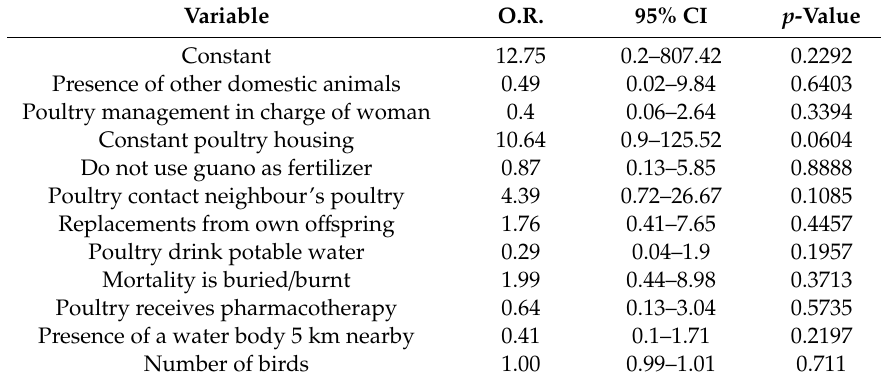
Table 3. Results of logistic regression to identify possible risk factors for the presence of antimicrobial residues in eggs in BPS from central